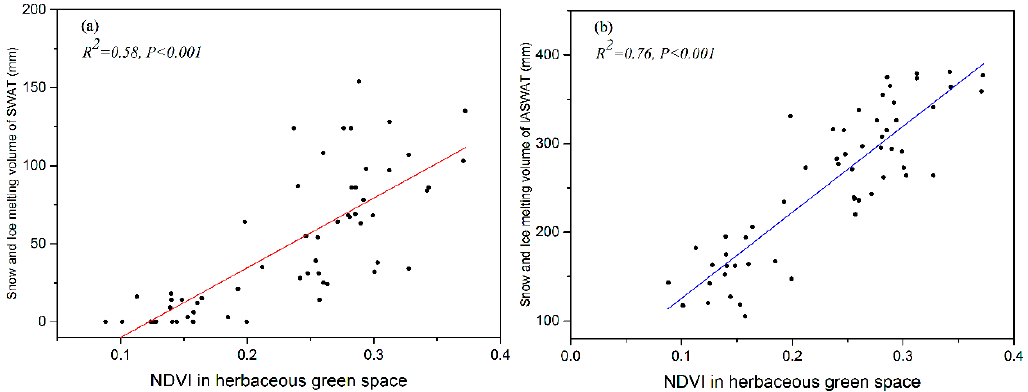
Figure7. RelationshipbetweentheherbaceousgreenspaceNDVIandsnowandicemelt: ( a )relationship Figure 7. Relationship between the herbaceous green space NDVI and snow and ice melt: (a) between the amount of snow and ice melt calculated by the SWAT model and the herbaceous green relationship between the amount of snow and ice melt calculated by the SWAT model and the space NDVI ; ( b ) relationship between the amount of snow and ice melt calculated by the SWATAI herbaceous green space NDVI; (b) relationship between the amount of snow and ice melt calculated model and the herbaceous green space by the SWATAI model and the herbaceous green space NDVI.